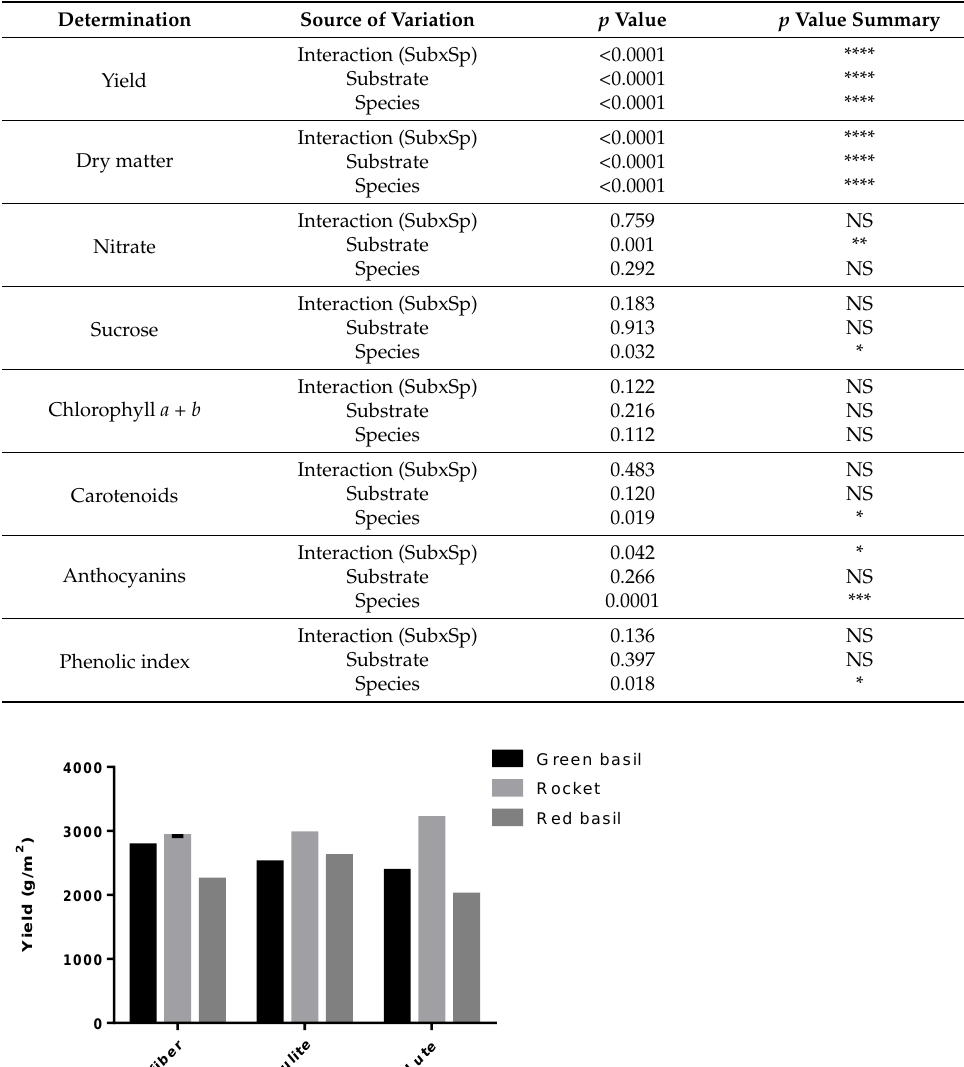
Table 1. Summary of the results of the two-way ANOVA for all the analyzes performed. Data were subjected to two-way ANOVA and Tukey’s multiple comparison test was used for evaluating the differences among means at (* p < 0.05, *** p < 0.001, **** p < 0.0001). NS = not significant. Determination Source of Variation p Value p Value Summary Interaction (SubxSp) <0.0001 <0.0001 Yield